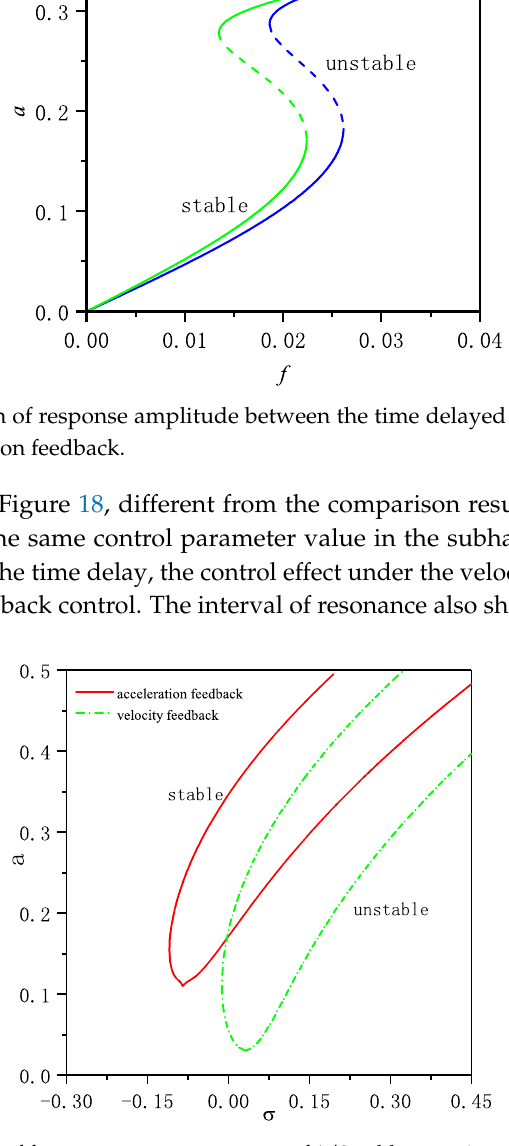
Figure 18. Comparison of frequency response curves of 1/3 subharmonic resonances response between the time delayed velocity feedback and the time delayed acceleration